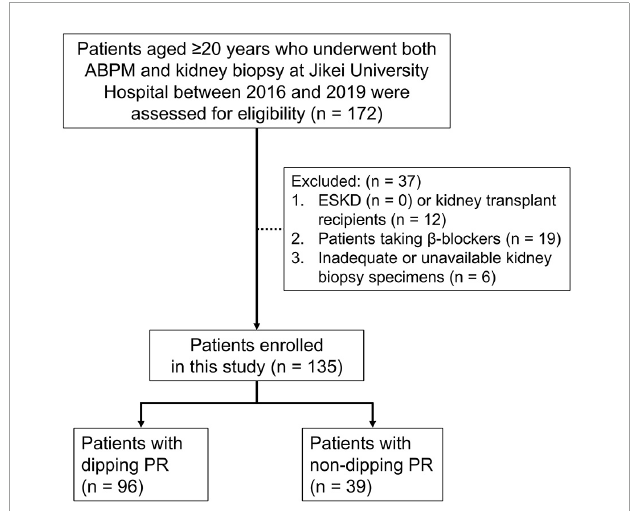
FIGURE1 Flow diagram of study participants. One hundred and seventy-two patients aged ≥ 20 years who underwent ABPM and kidney biopsy at our institution between March 2016 and March 2019 were assessed for eligibility. Of these patients, 37 were excluded from this study due to the exclusion criteria. ABPM, ambulatory blood pressure monitoring; ESKD, end-stage kidney disease; PR, pulse rate.